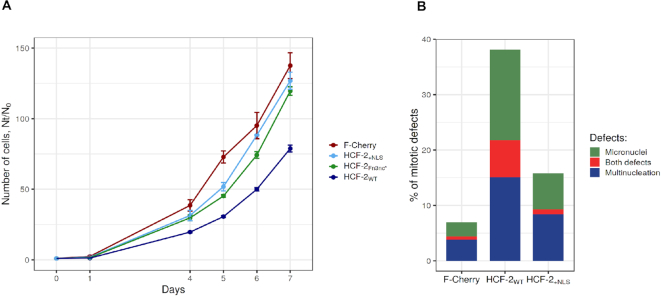
Ectopic HCF-2 synthesis affects cell proliferation (A) and promotes mitotic defects (B). (A) Growth curves of HEK-293 T-REx cells with induced F-Cherry, F-Cherry-HCF-2WT, F-Cherry-HCF-2+NLS or F-Cherry-HCF-2Fn3nc* synthesis during 7 days after doxycycline addition at day 0. (B) Percentage of cells with mitotic defects (micronuclei, green; multinucleation, blue; or both, red) in F-Cherry, F-Cherry-HCF-2WT and F-Cherry-HCF-2+NLS containing cells 72 h after doxycycline induction.